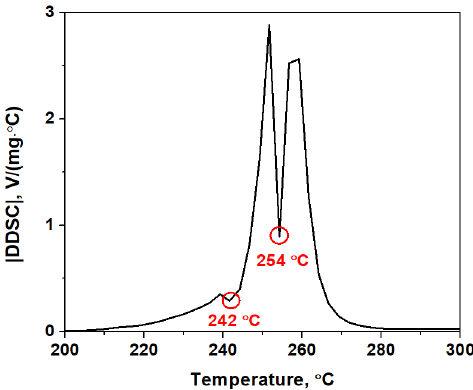
Figure 5. |DDSC| curve obtained at DSC data differentiating (Figure 4b).